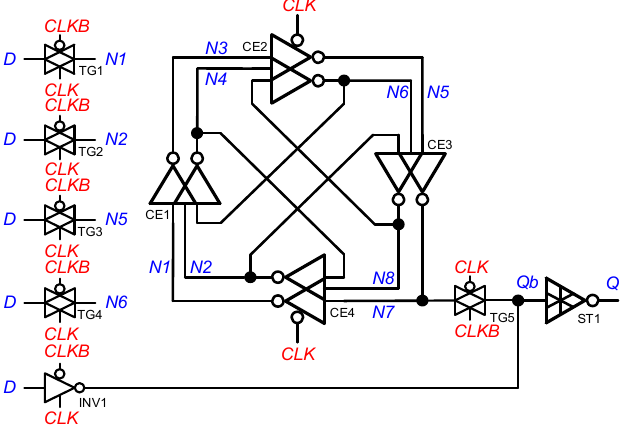
Figure 4. Circuit diagram of the proposed design DNURF.